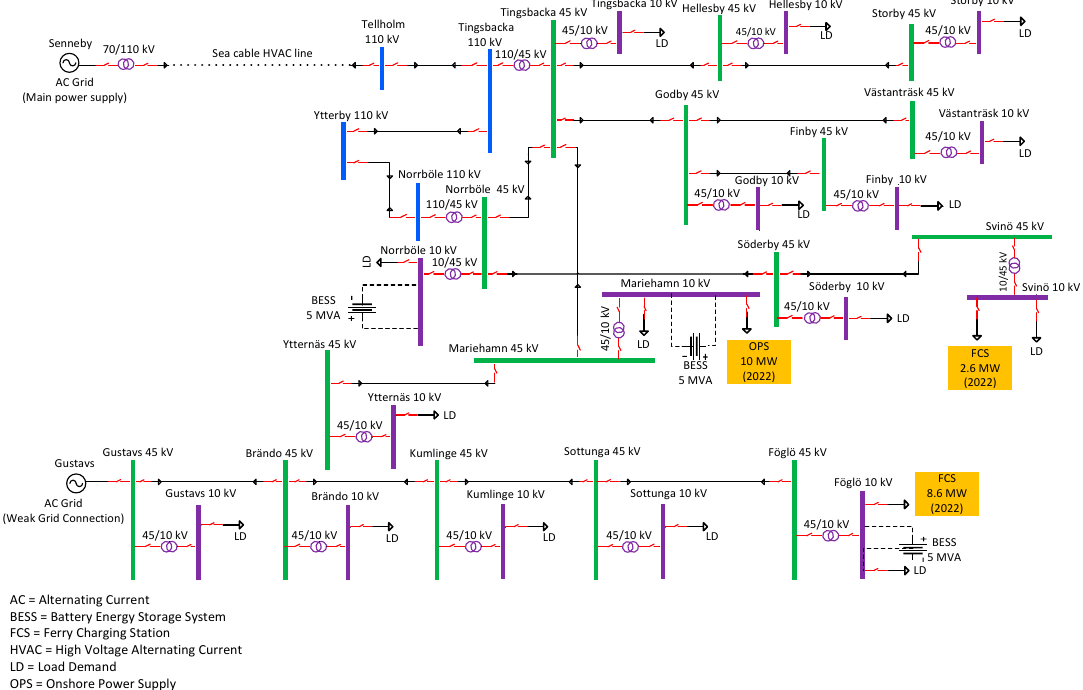
Figure 11. Radial mode operation of the Åland Islands’ power system for the year 2022 with BESSs.